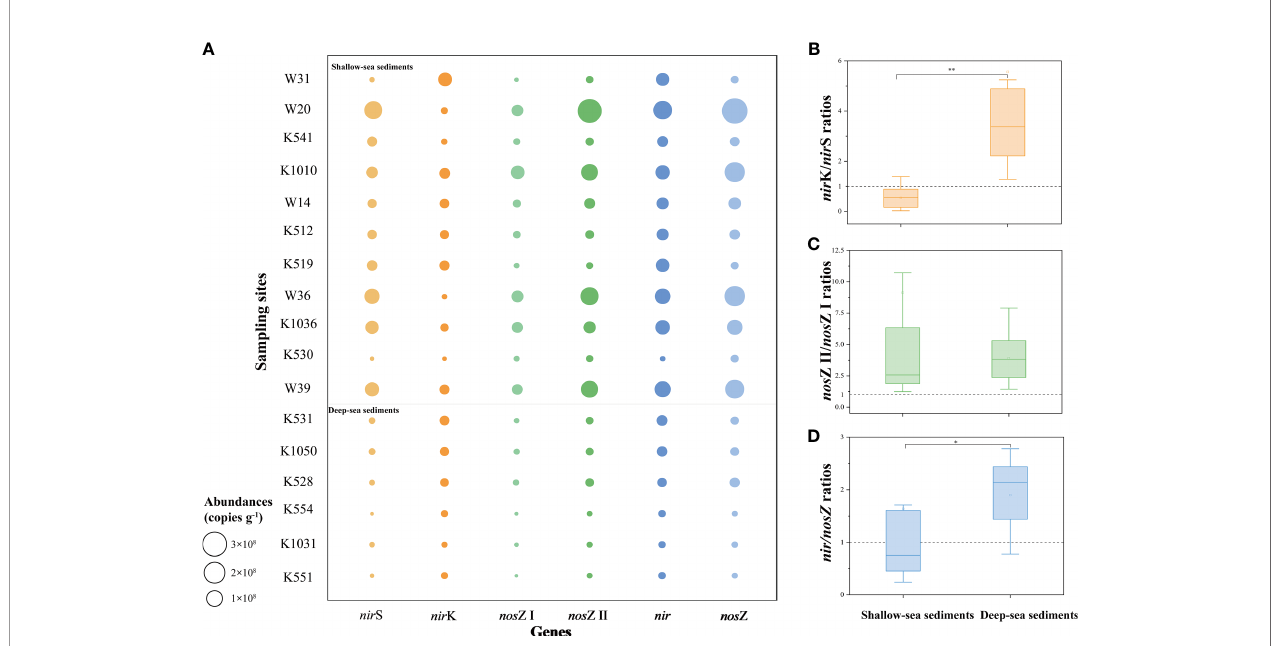
FIGURE 2 | Abundances and ratios of key functional genes for denitri fi cation in surface sediments of SCS. The gene abundances include the nir ( nir S and nir K) and nos Z ( nos Z I and nos Z II) genes (A) , gene ratios include the nir K/ nir S gene abundance ratios (B) , the nos Z II/ nos Z I gene abundance ratios (C) and the nir / nos Z gene abundance ratios (D) . The asterisks denoted statistically differences by Mann-Whitney test, two asterisks (**) denotes p < 0.01 and one asterisk (*) denotes p <